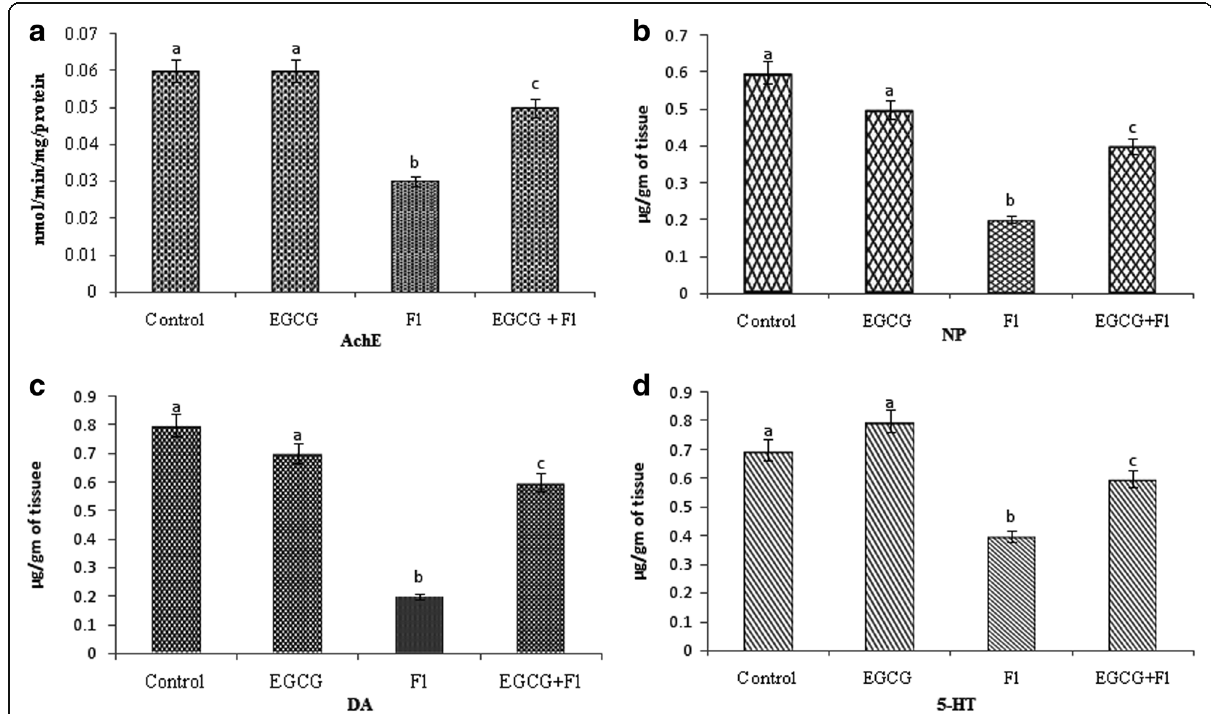
Fig. 2 a – d Changes in the activities of acetylcholinesterase (AChE) norepinephrin (NP), dopamine (DA), and 5-hydroxytrophoamin (5-HT) in the brain of control and experimental rats. ATCI: acetyl thiocholine iodide. Values are mean ± SD for six rats in each group. Values not sharing a common superscript letters (a, b, and c) differ significantly at p < 0.05